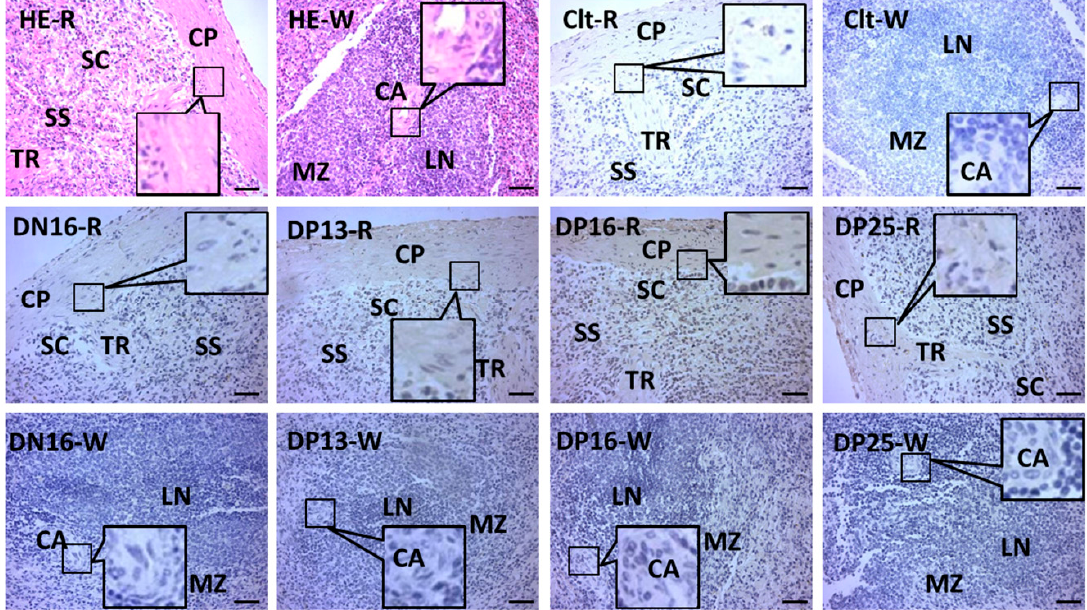
Figure 3. Representative immunohistochemical localization of STAT1 protein in ovine spleens. The spleen is divided into red pulp (R) and white pulp (W), and surrounded by a thickened capsule. Capsule (CP) with several trabeculae (TR) projects into the substance of the spleen. Note: HE = stained by hematoxylin and eosin; SS = splenic sinuses; SC = splenic cords; MZ = marginal zone; LN = lymphoid nodule; DN16 = day 16 of the estrous cycle; DP13 = day 13 of pregnancy; DP16 = day 16 of pregnancy; DP25 = day 25 of pregnancy. Bar = 50 μ m.